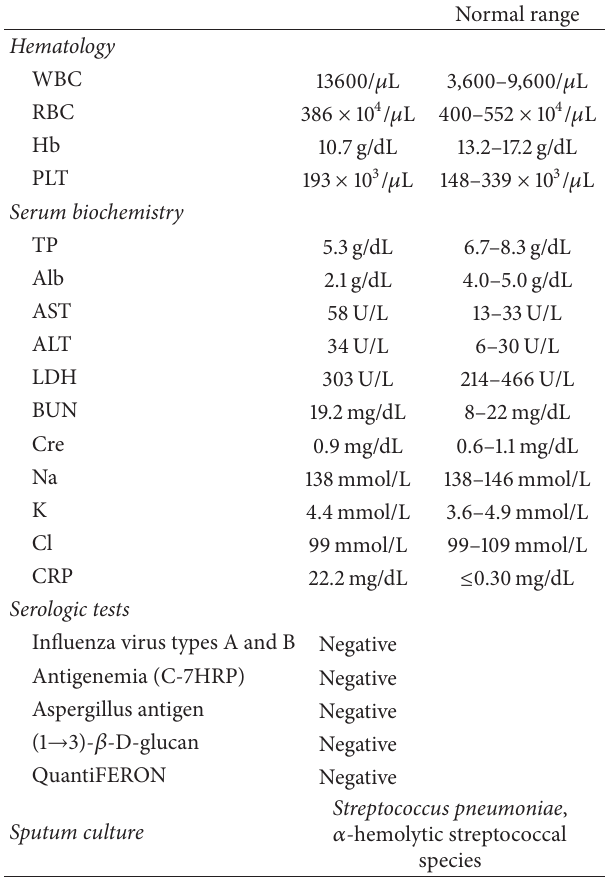
Table 1: Laboratory findings on